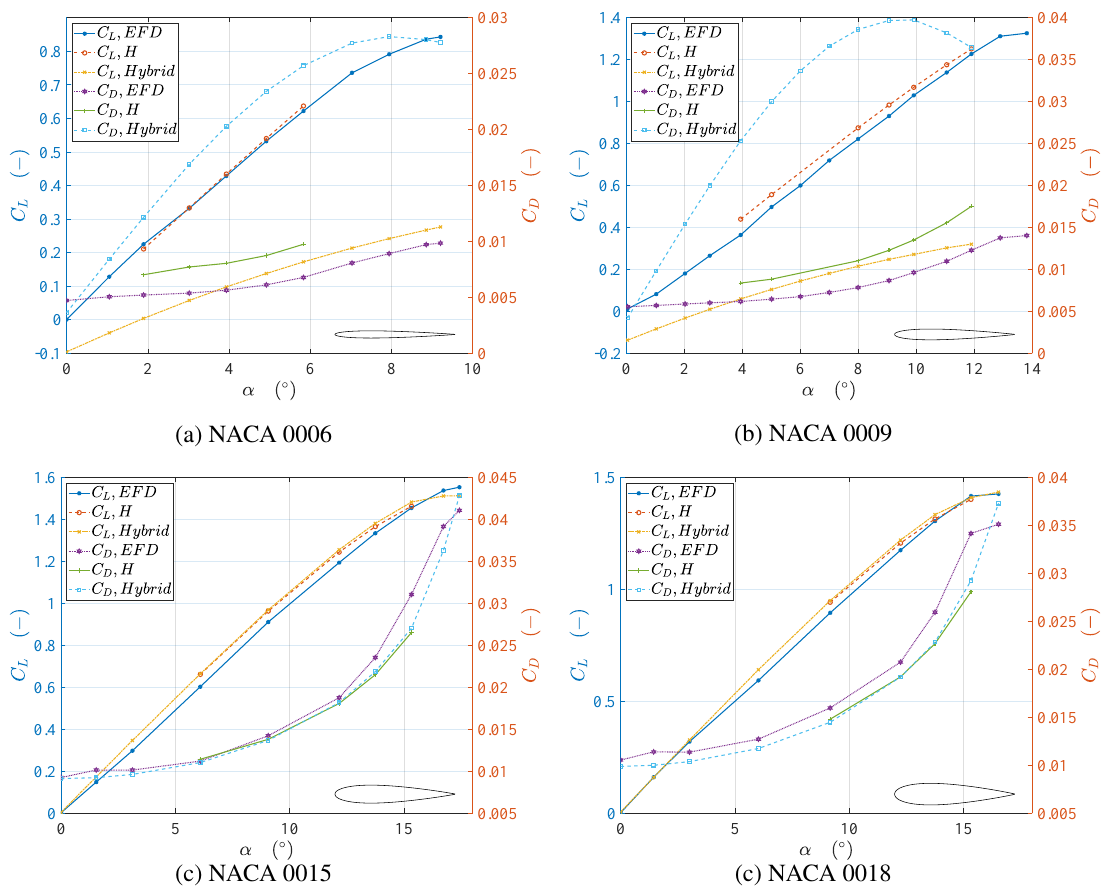
Figure 20. Comparison of results of H and Hybrid mesh with experimental benchmark data adopted from [39,40] for NACA 0006, NACA 0009, NACA 0015 and NACA